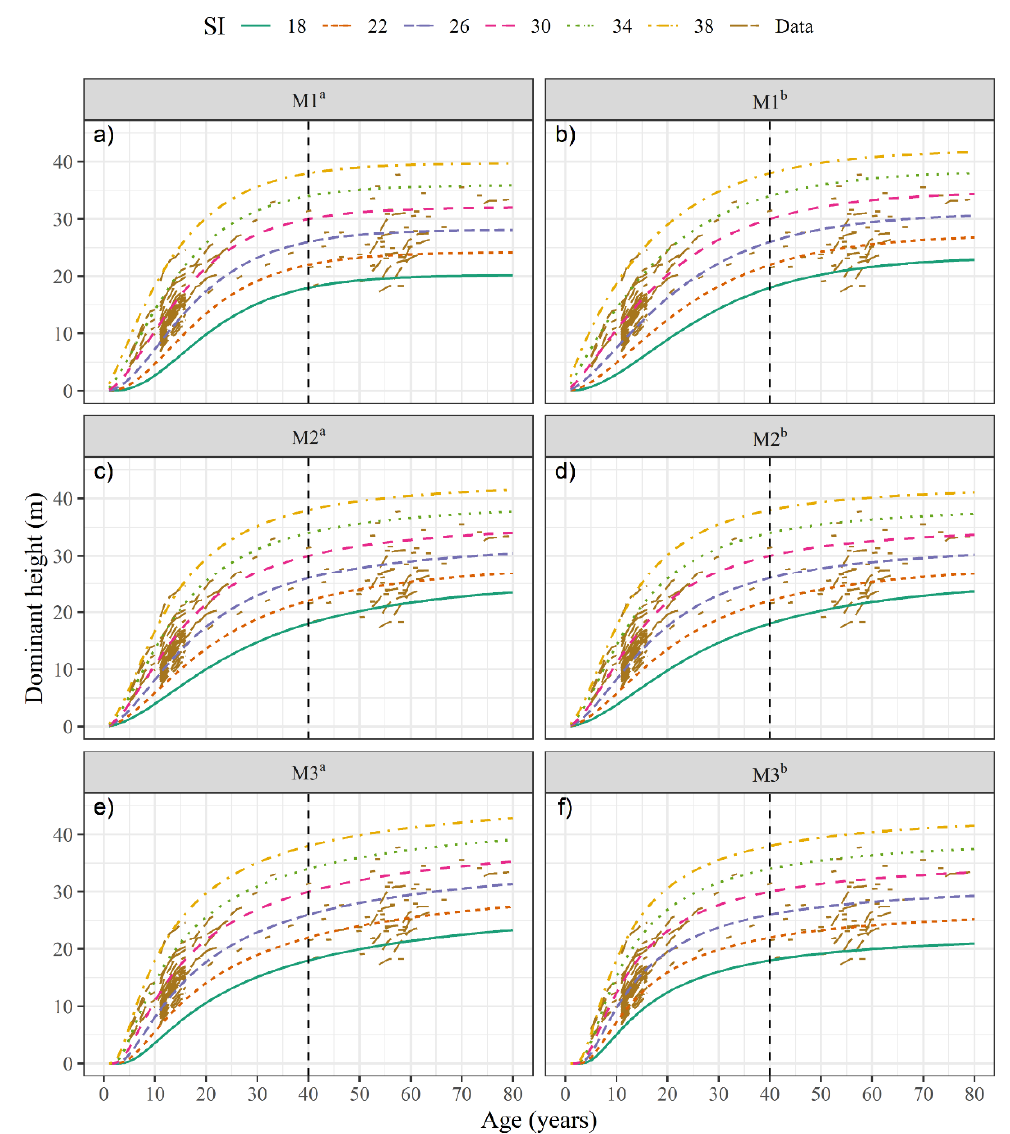
Figure 2. Site index curves for patula pine at a base age of 40 years. M1: Chapman-Richards ( a , b ), M2: Hossfeld IV ( c , d ), M3: Korf ( e , f ). a Fitting without the addition of site topographic and climatic variables, and b fitting with the addition of site topographic and climatic variables.